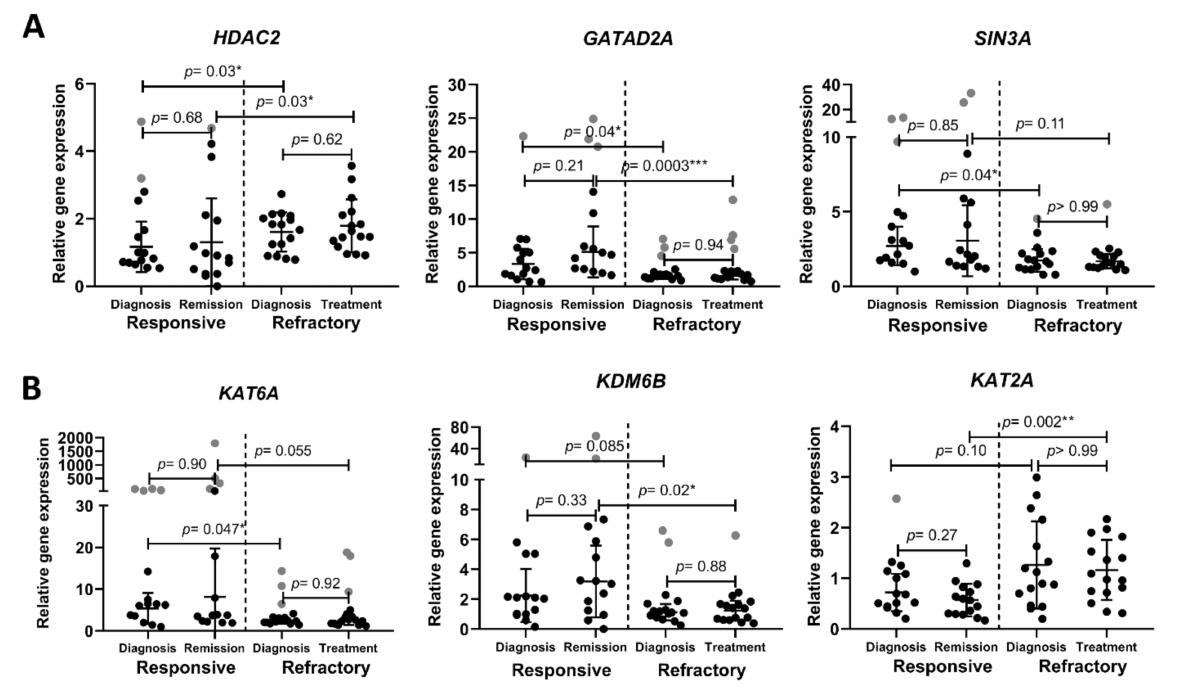
Figure 2. Chromatin-remodeling-related gene expression analysis in treatment-responsive and -refractory AML patients. ( A ) Gene expression changes of transcription-repressing histone modifica- tors; ( B ) gene expression changes of transcription-activating histone modificators. Cell samples were collected at diagnosis stage and after treatment. Relative gene expression analysis was performed using the RT-qPCR ∆∆ Ct method; GAPDH was used as a “housekeeping” gene. Mean ± standard deviation is presented; grey data points indicate outliers. Mann–Whitney U test was used to deter- mine the significance of difference between groups of different patients’ samples, and significance was set at p ≤ 0.05 (*). Outliers were determined by ROUT (Q =